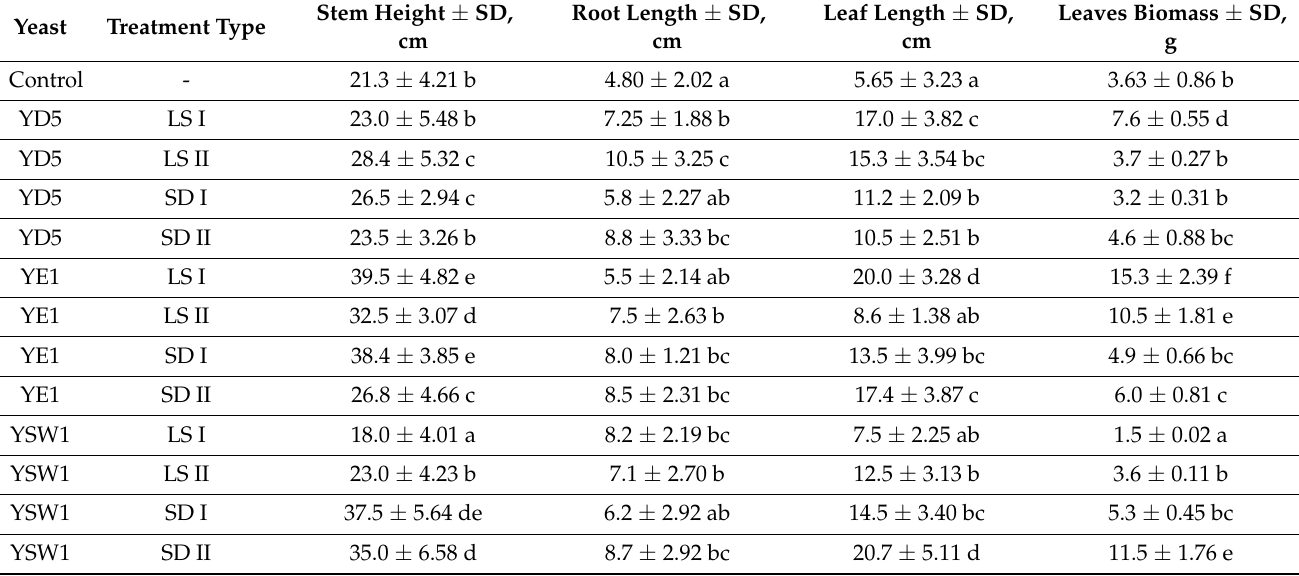
Table 3. Influence of biocontrol yeast on the growth parameters of tobacco plants. Tobacco plants were treated by soil drench (SD) and leaf spraying (LS), and measurements were taken on the 28th DAT (I: first treatment) and the 14th DAT (II: second